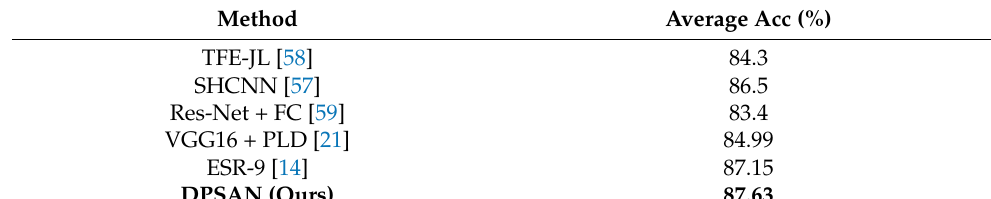
Table 3. Comparison of DPSAN with other models on the FERPLUS dataset.